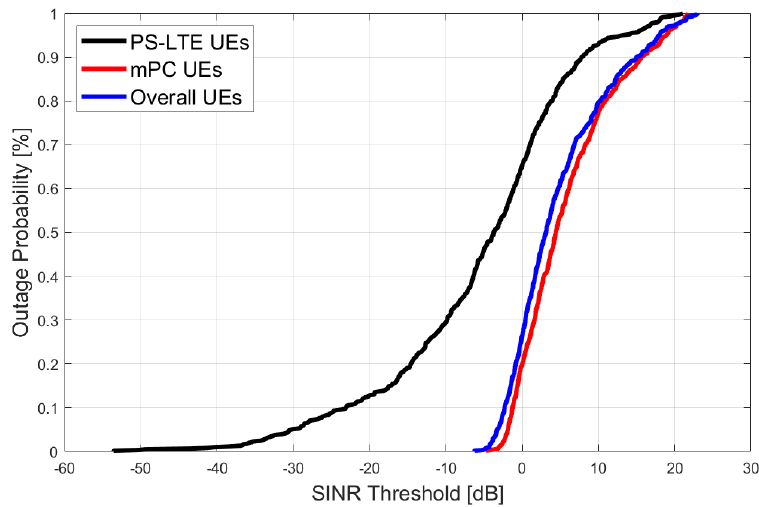
Figure 6. UE outage probability. Figure 6. UE outage